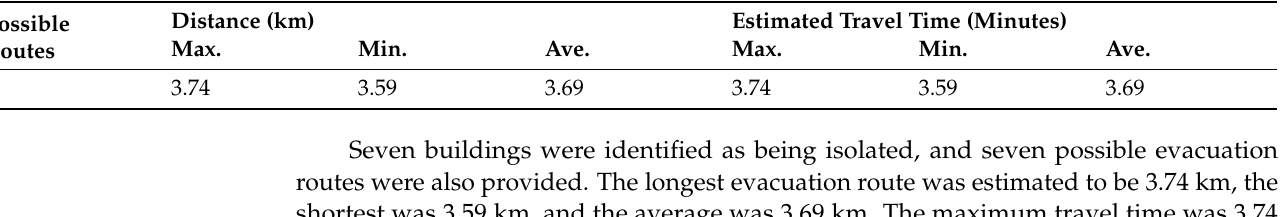
Table 5. Length of the evacuation route and the travel time by vehicle from the isolated area of Samsan-ri to the nearest shelter.